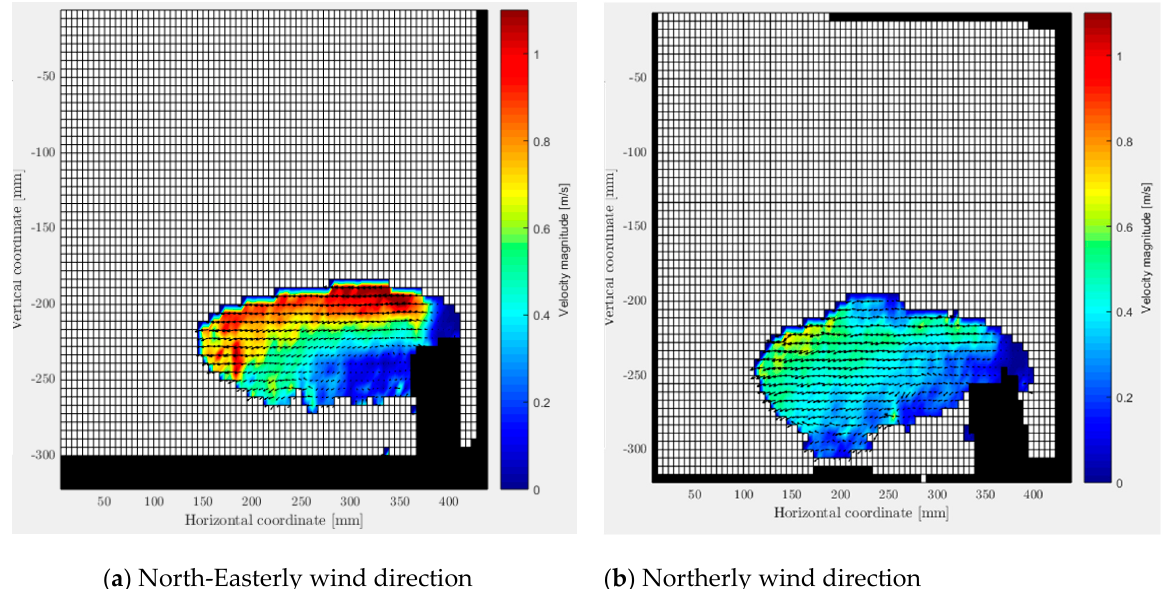
Figure 11. Wind velocity field results for ( a ) North-Easterly and ( b ) Northerly wind directions demonstrating its effects on the exhaust smoke dispersion (for an inflow condition of 1 m ∙ s − 1 ).